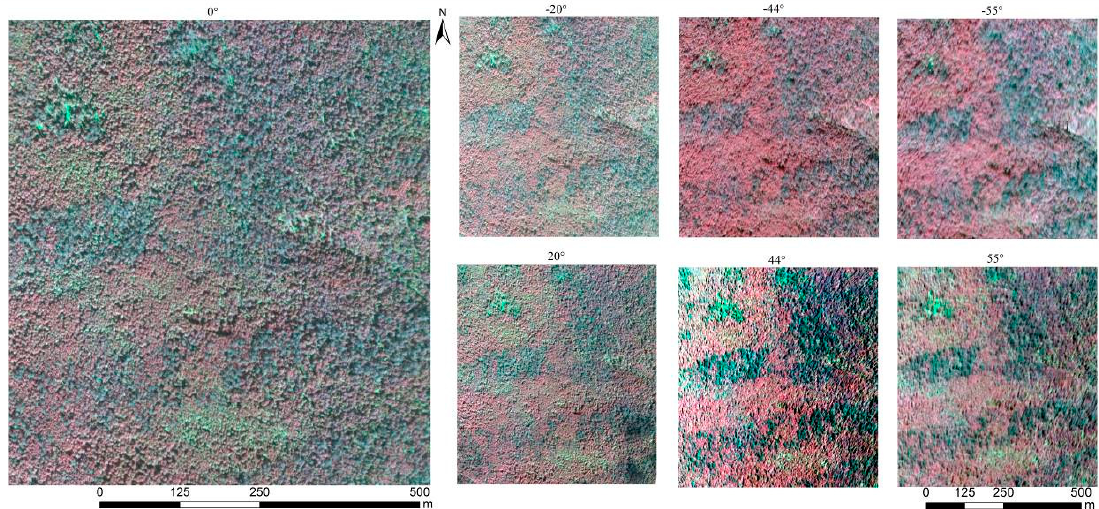
Figure 8. Multi-angle hyperspectral data from CAF-LiCHy AOP system in Greater Xing’an Mountains. The RGB false color channels are 858.99 nm, 647.19 nm, 553.02 nm respectively. The view angles include 0°, − 20°, − 44°, − 55°, and 20°, 44°, 55°.